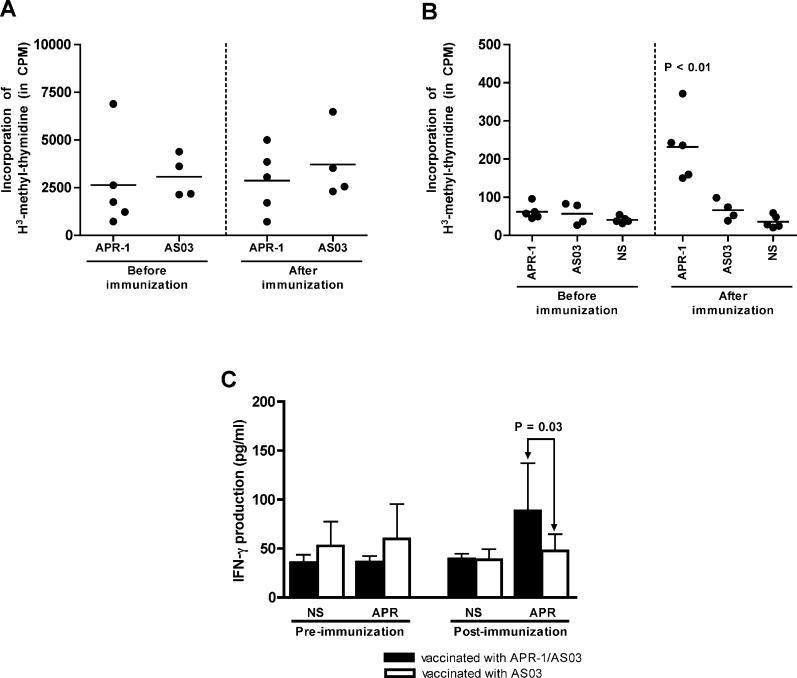
Canine Cellular Immune Response to Vaccination with Recombinant Ac-APR-1Cell proliferation of whole blood cells from vaccinated (APR-1) and control dogs (AS03) when stimulated with concanavalin A (A) or recombinant Ac-APR-1 (B) before (day 0) and after the final immunization (day 51). The p-value comparing the mean differences between the vaccinated group and controls is denoted. Detection of secreted IFN-γ in whole blood cultures taken from vaccinated and control dogs before and after immunization (C). Mean cytokine concentrations are indicated in pg·ml−1 with standard error bars. Statistically significant differences are indicated above the bars by p-values. APR, stimulated with recombinant APR-1; NS, non-stimulated cultures.